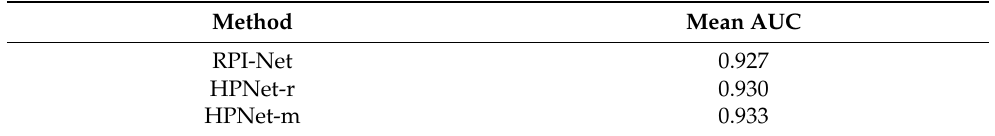
Table 3. Mean AUCs of three debiasing